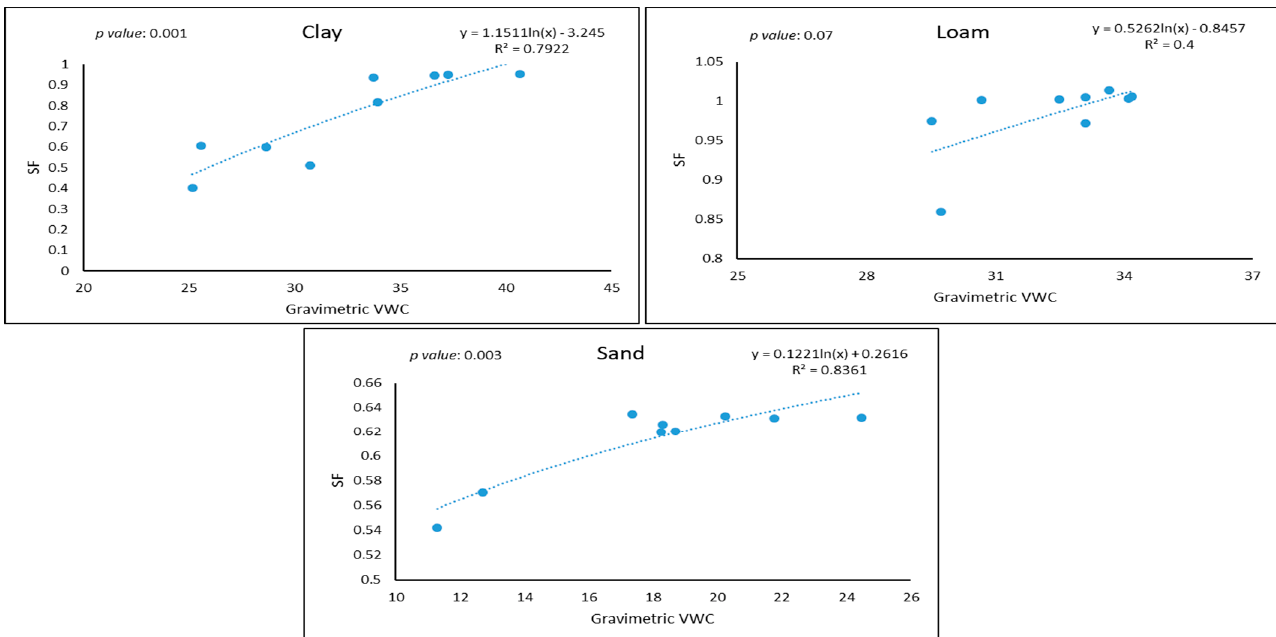
Figure 7. Fitting regression analysis of phase one field calibration.